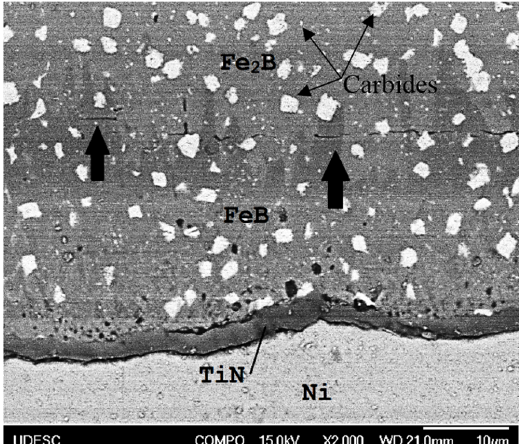
B interface showing the crack 2